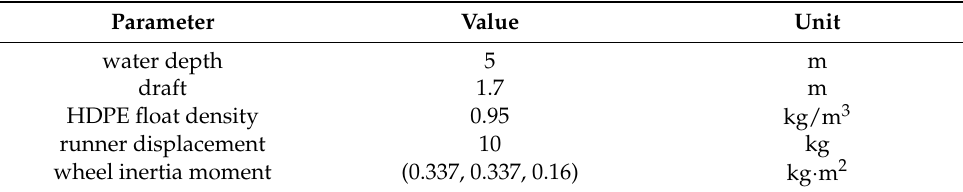
Table 2. Hydrodynamic parameters of floating